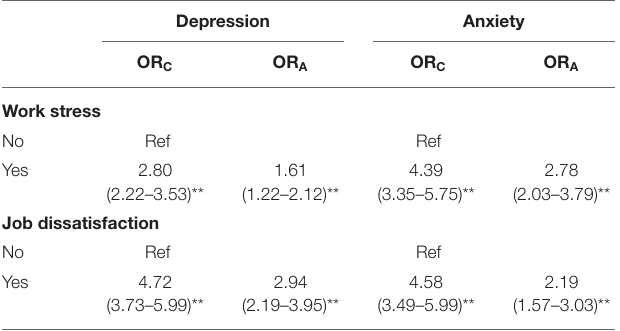
TABLE 2 | Logistic regression analysis of related variables on mental health problems.